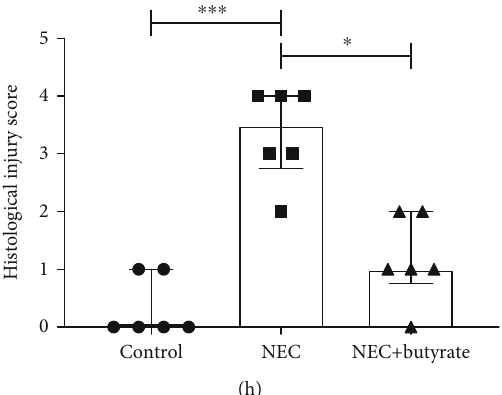
Figure 2: (a) Visual morphological observation of intestinal tissue from newborn mice in the three groups. (b – g) Histopathological observation of the terminal ilea in the three groups; images of HE staining observed by microscopy; (b, c) control group; (d, e) NEC group; (f, g) NEC+butyrate group. Magni fi cation: 40x and 100x; scale bar = 100 μ m. (h) The intestinal histopathological injury scores in the three groups. Number of samples: control ( n = 6 ), NEC ( n = 6 ), and NEC+butyrate ( n = 6 ). Statistical analysis: Kruskal-Wallis test. ∗ P < 0 : 05 ; ∗∗∗ P < 0 : 001